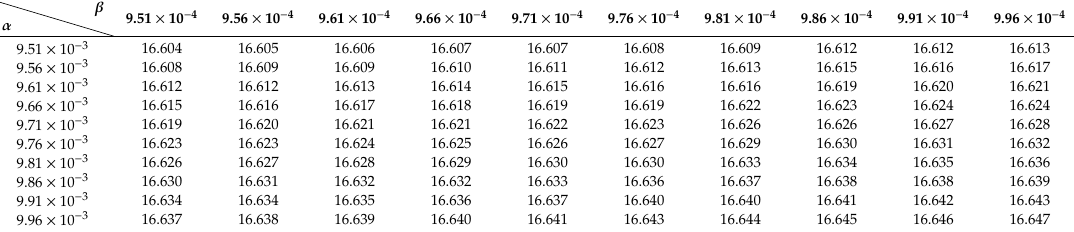
Table 7. Weddell Seal with di ff erent α , β corresponding to SNR data.